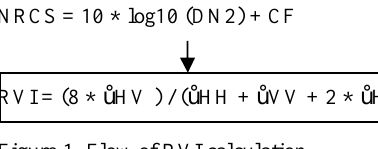
Figure 1. Flow of RVI calculation